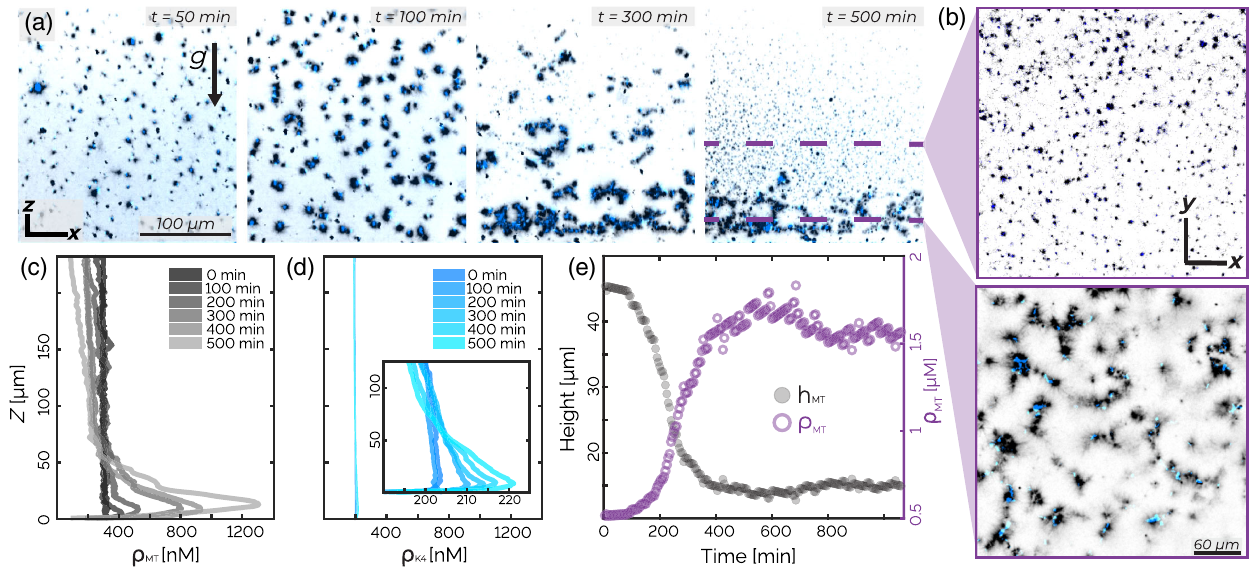
FIG. 3. Active asters: Initial conditions determine steady-state dynamics. (a) x - z plane images show the aster assembly and sedimentation. The arrow indicates gravity; x - y is the imaging plane. (b) Aster images in the x - y at two different heights at 500 min. (c),(d) Temporal evolution of the density z profiles of microtubules ρ average microtubule density (purple open circles) below the sedimentation height (black circles) as a function of time. The effective microtubule concentration is higher than what is used in Fig. 2, yet no global contraction